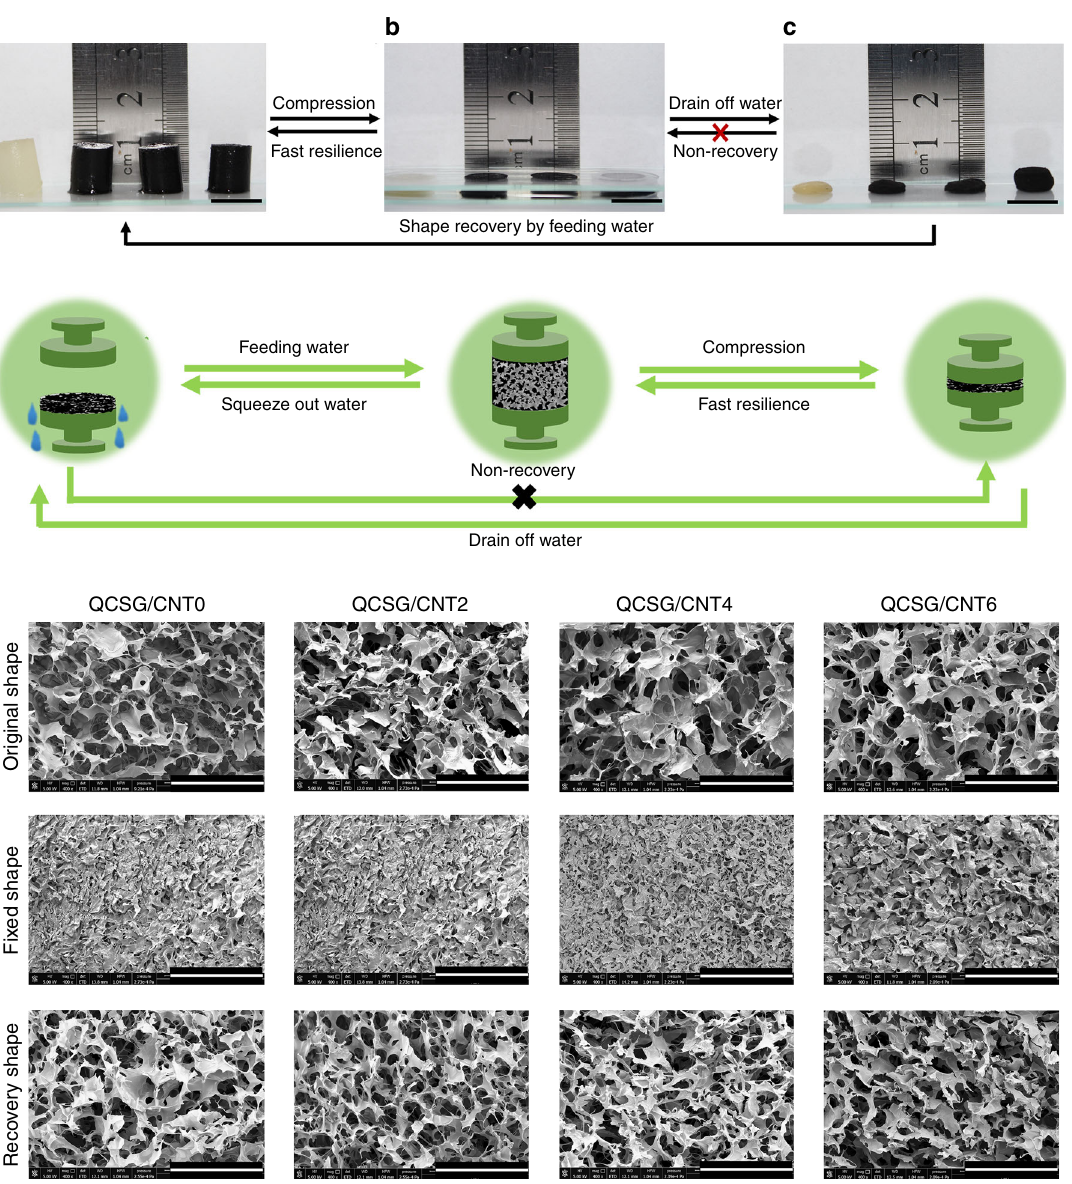
Fig. 4 Shape memory properties of the cryogels. a – c Fast resilience and macroscopical shape memory property of the cryogels. Scale bar: 1 cm. d Schematic representation of the shape memory mechanism of the cryogel. e Microtopography of the cryogels in original state, shape- fi xed state and shape recovery state after fi xing. Scale bar: 400 μ m. All the four cryogels under free shape showed interconnected macroporous structure with similar pore size between 100 – 200 µ m. Compared to their shapes under free situation, all the shape- fi xed cryogels presented collapsed and almost closed pores except QCSG/ CNT6 still remained unclosed pores with reduced pore size. However, all the four shape- fi xed cryogels still kept unbroken network. After absorbing water, all the cryogels ’ morphologies were similar to those in original